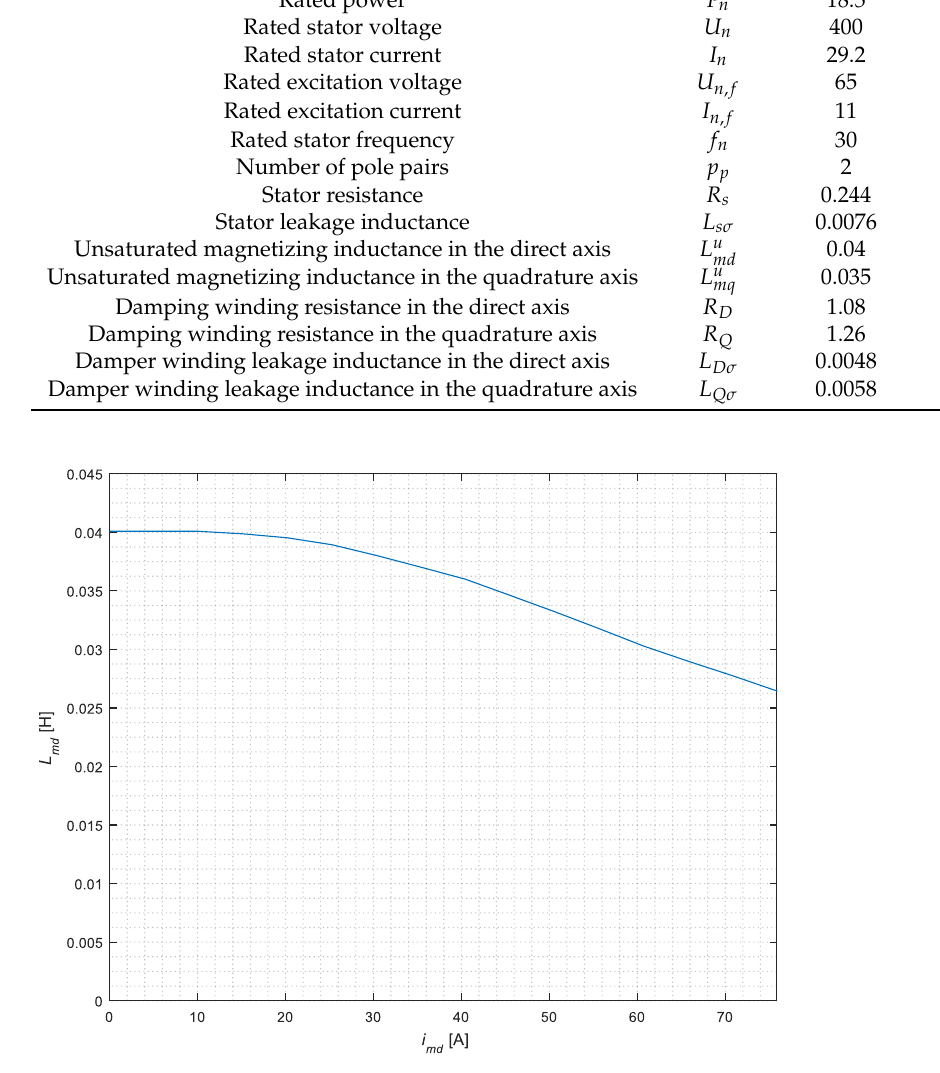
Figure A1. Open circuit saturation curve in the direct axis.